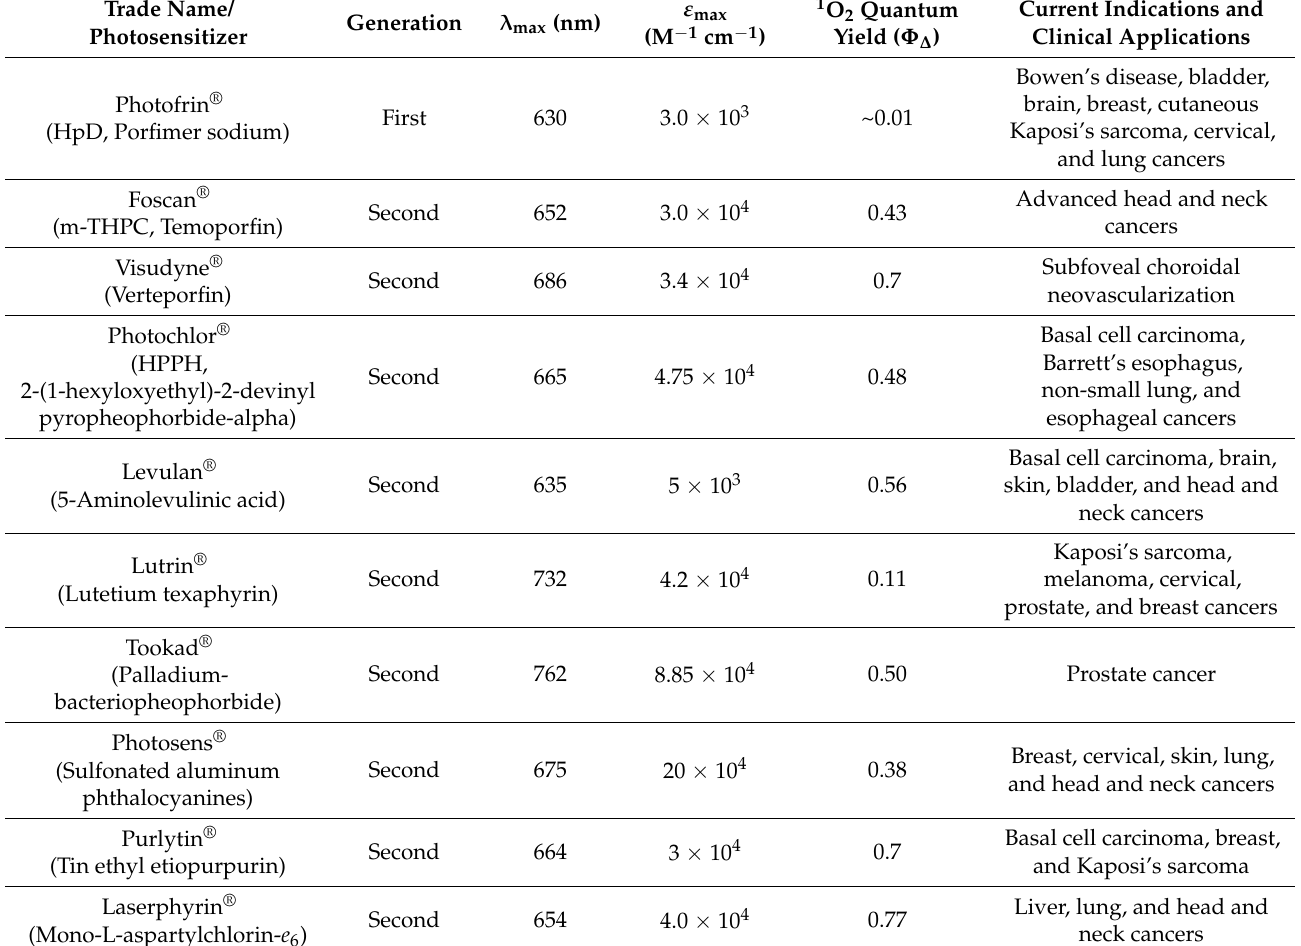
Table 2. Summary and classification of photosensitizers used in clinical studies